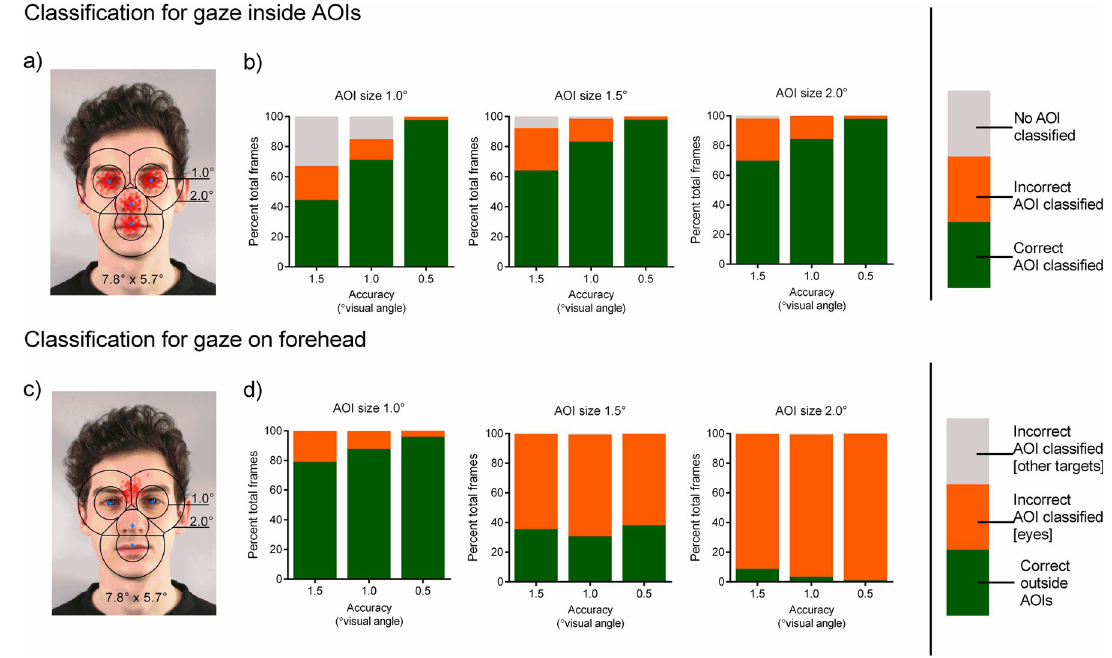
Fig 3. Effect of gaze data accuracy and AOI size on classification performance of simulated fixations (on eyes, nose & mouth) averaged over all facial AOIs. (A) Visualization of the AOI sizes 1.0˚ and 2.0˚ drawn around the blue center points and the simulated fixation points in red (n = 100, averaged over 30 simulated fixations; accuracy 0.5˚). (B) Green indicates correct classification within the corresponding AOI, orange and gray indicate misclassifications as fixations within the other AOIs, or no AOI at all. Effect of gaze data accuracy and AOI size on classification performance of simulated fixations (on the forehead). (C) Visualization of AOIs with 1.0˚ and 2.0˚ radius and the simulated fixation points on the forehead in red (n = 100, averaged over 30 simulated fixations; accuracy 0.5˚). (D) Green indicates the correct classification outside any AOI, orange and gray indicate misclassifications as fixations within the AOIs of the eye region or within the other AOIs. The stimulus shown in A and C was created for illustrative purposes only and is not part of the stimulus set used in the study (see Methods